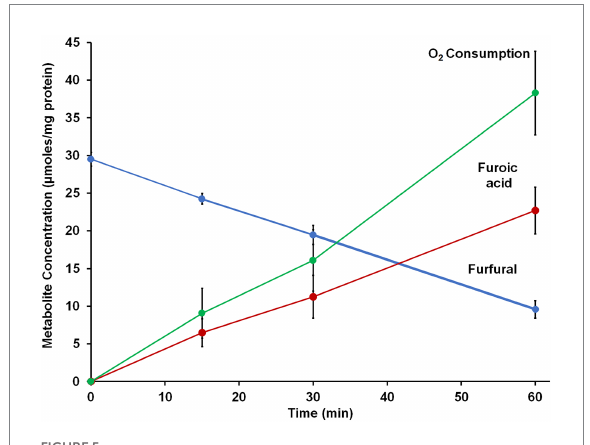
FIGURE 5 Furfural oxidation activity of BmWOR in the presence of oxygen. Purified BmWOR was assayed using 1.5 mM furfural in the presence of 10 μ M B. massilliensis Fd in closed serum vials containing 7% (v/) oxygen in the headspace. At indicated intervals, headspace samples were removed to determine the oxygen consumption and liquid samples were removed to determine furfural and furoic acid